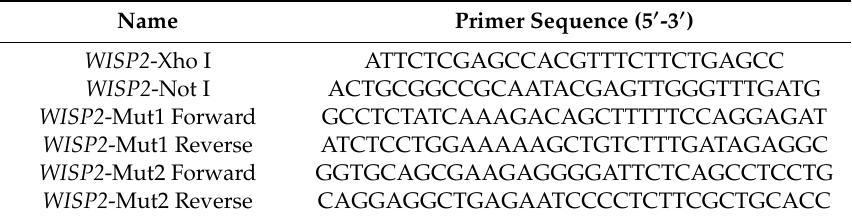
Table 2. Sequence of primers for plasmids construction and